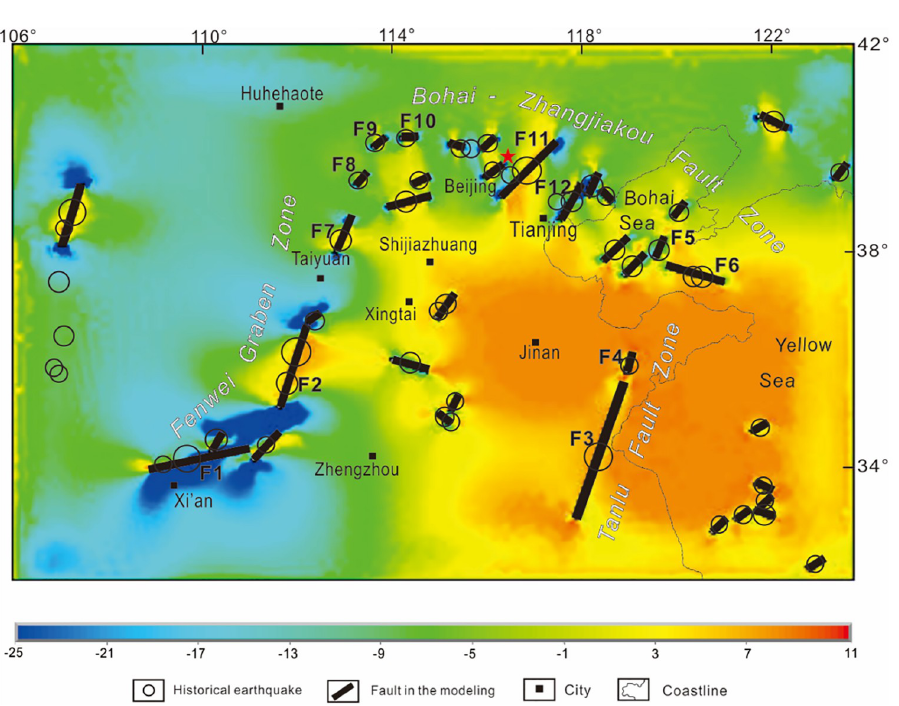
Fig 6. Minimum principal strain value calculated by the model and historical earthquakes in the CNCB. Black lines denote the seismogenic faults. An approximately E-W-trending extension is located in the east-central part of the research area, while an approximately N-S-trending shortening is located in the west